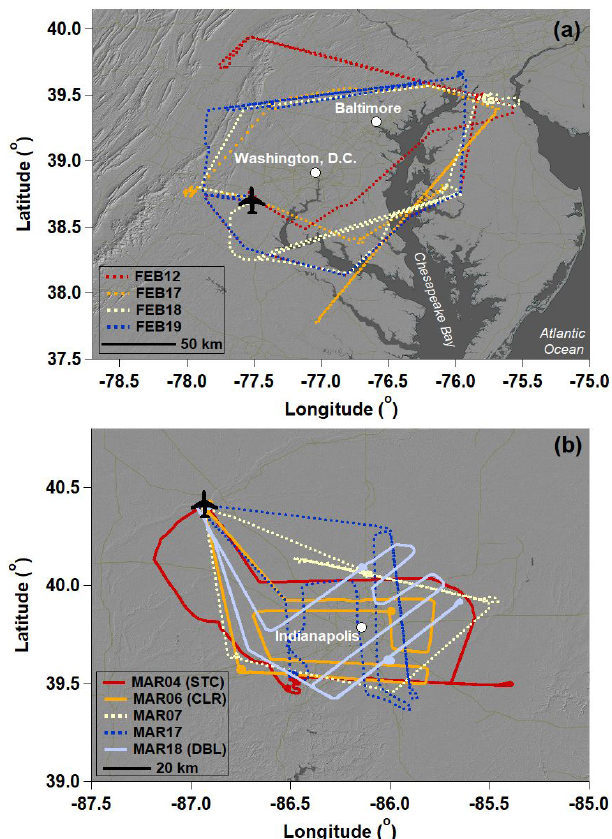
Figure 2. Flight paths conducted around the (a) Washington, D.C. and Baltimore, MD, and (b) Indianapolis study sites for the research flights listed in Table 1. Case study flight paths are indicated with solid lines, while all other flight paths are indicated with dotted